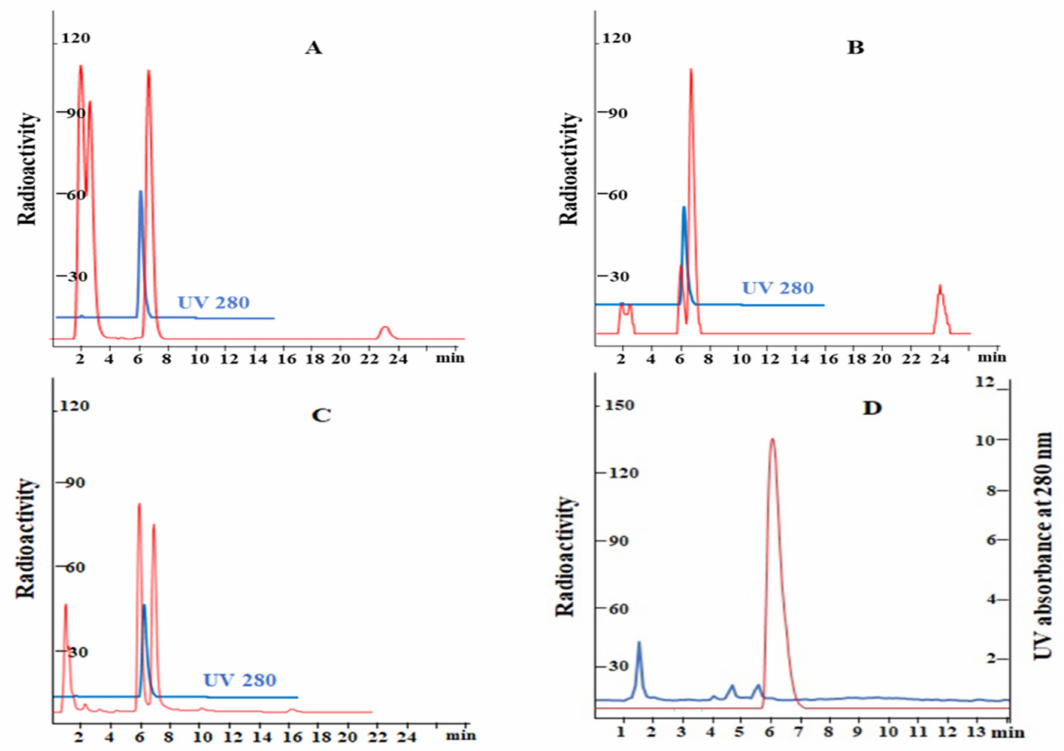
Figure 5. ( A – C ) panels—HPLC radiochromatograms of the crude reaction mixture after deprotecting of 17 , ( A , B )—KOMe and NaOH, respectively, used as bases in [ 18 F]fluoroethylation of 15 ; ( C )—NaOH used in [ 18 F]fluoroethylation of 5-propyl- 1,1 (cid:48) -biphenyl-2,4 (cid:48) -diol; blue line—UV chromatogram of unlabeled F-IV (reference compound). ( D )—Chromatograms for HPLC analysis of the formulated radioligand [ 18 F]F-IV (red line for radio- and blue line for